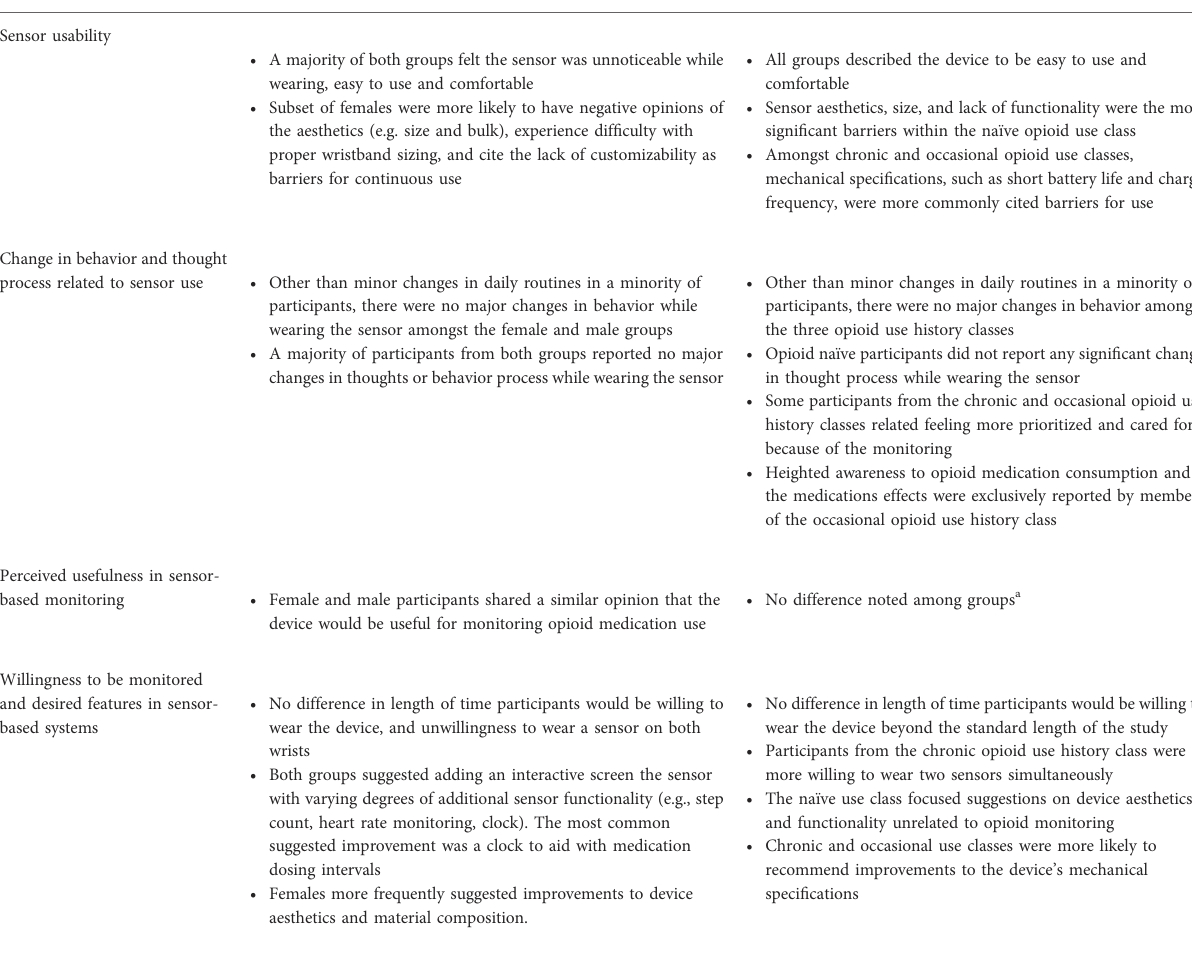
TABLE 3 Framework matrix table of themes by sex and opioid use history (naïve, chronic, occasional). Sensor